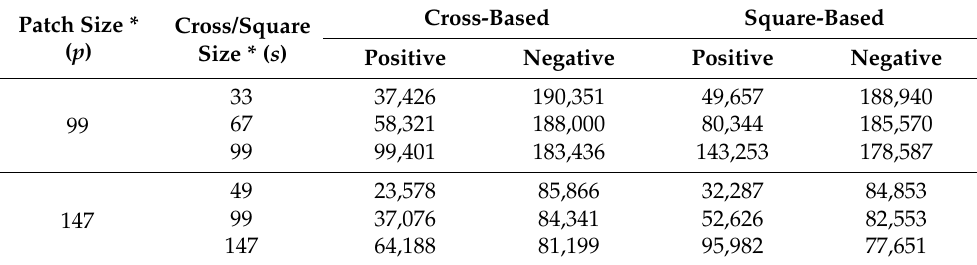
Table 3. The number of generated image patches for training CNNs. Patch Size